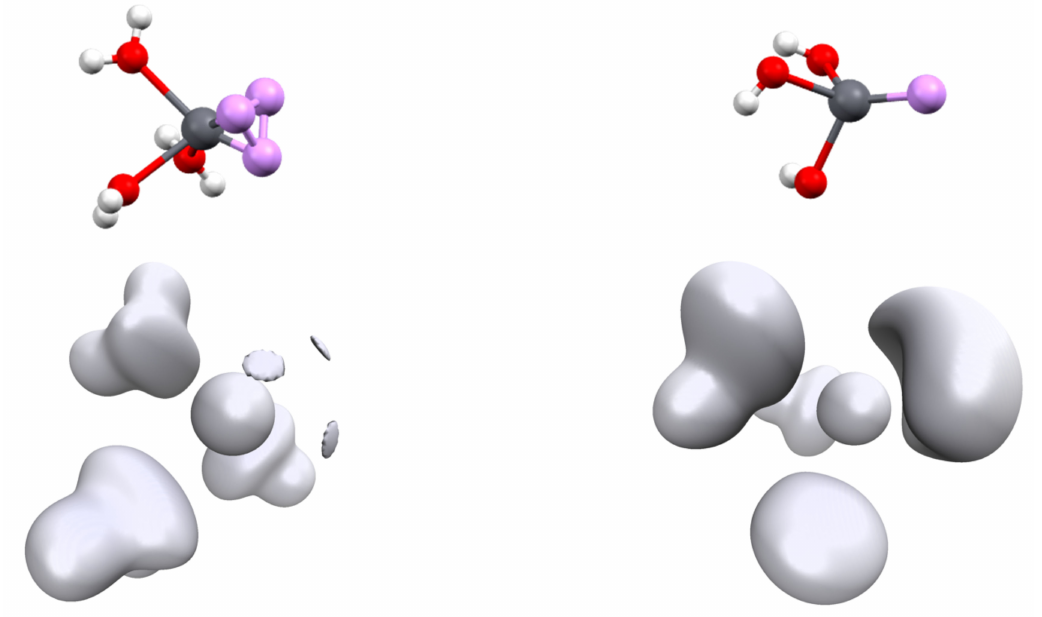
Figure 5. Position of the V(Pb) attractors ( top ) and associated ELF isosurface ( η = 0.59, ( bottom )) of [Pb(OH 2 ) 3 ] 2+ ( left ) and [Pb(OH) 3 ] − ( right )